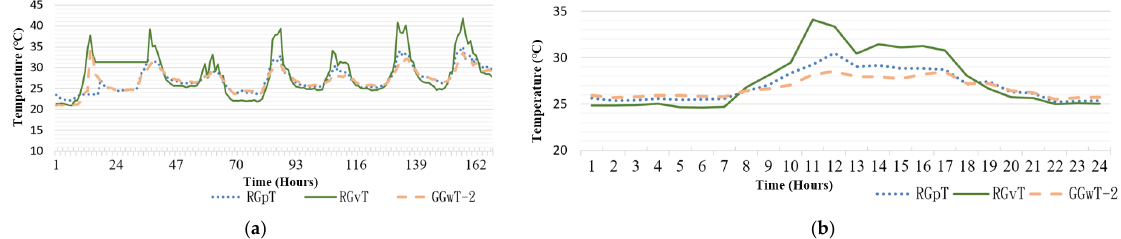
Figure 11. ( a ) Rooftop temperature with greening ( b ) partial observation on 21 May.